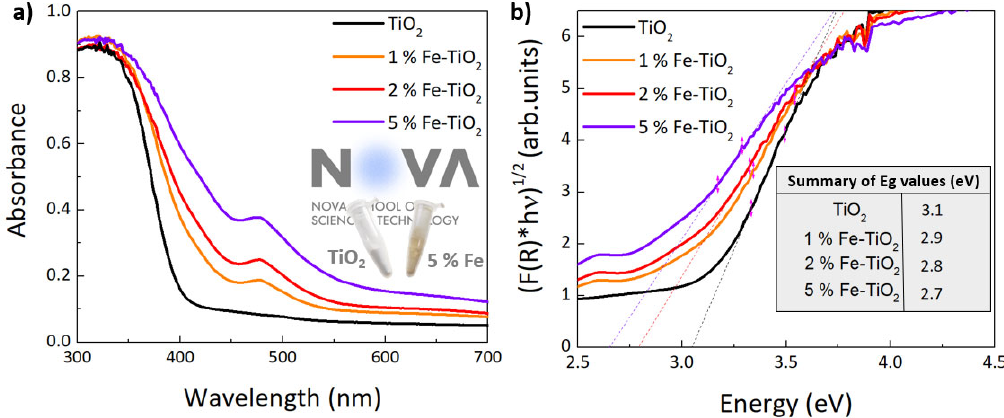
Figure 7. ( a ) Absorption curves and ( b ) optical band gaps estimation of TiO 2 and 1, 2, and 5 % mol of Fe ‐ TiO 2 catalysts with PEG synthesized by microwave irradiation.